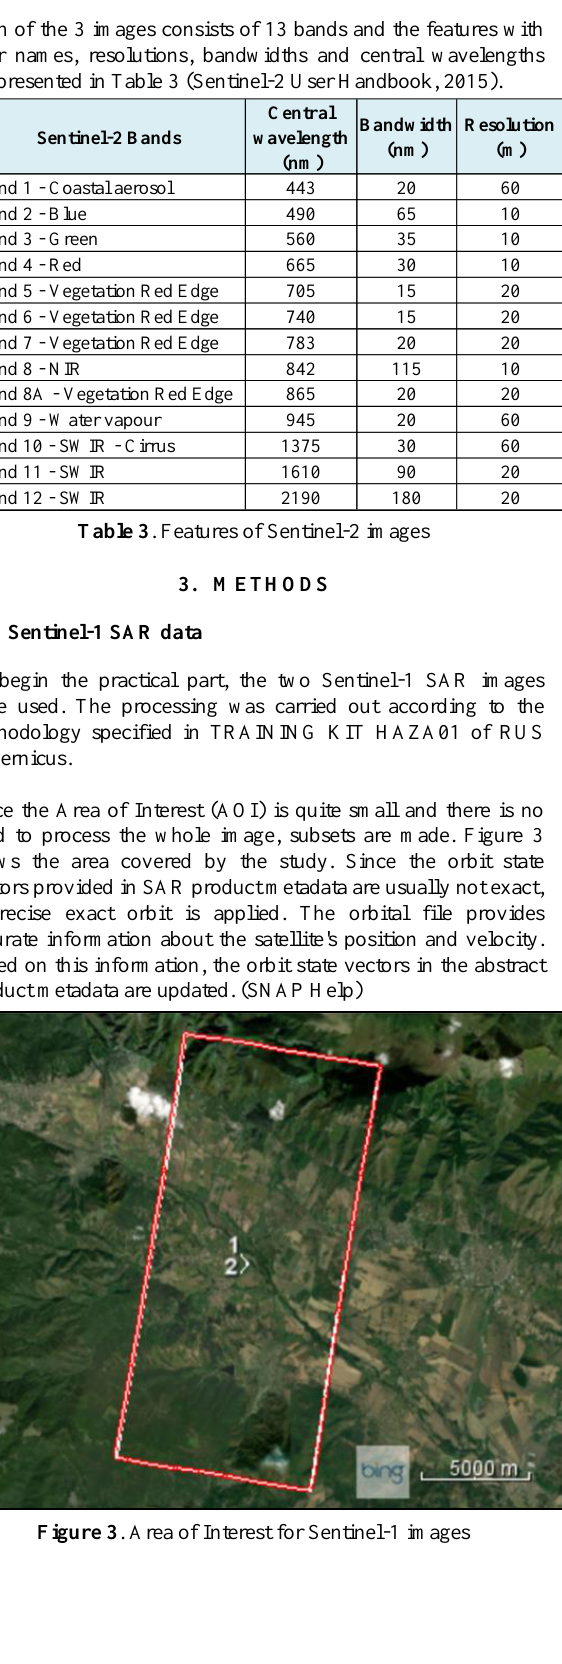
Table 2 . Specifications of Sentinel-2 images